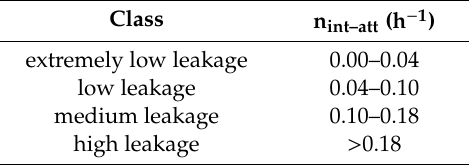
Table 2. Classes of the real interior–attic air change